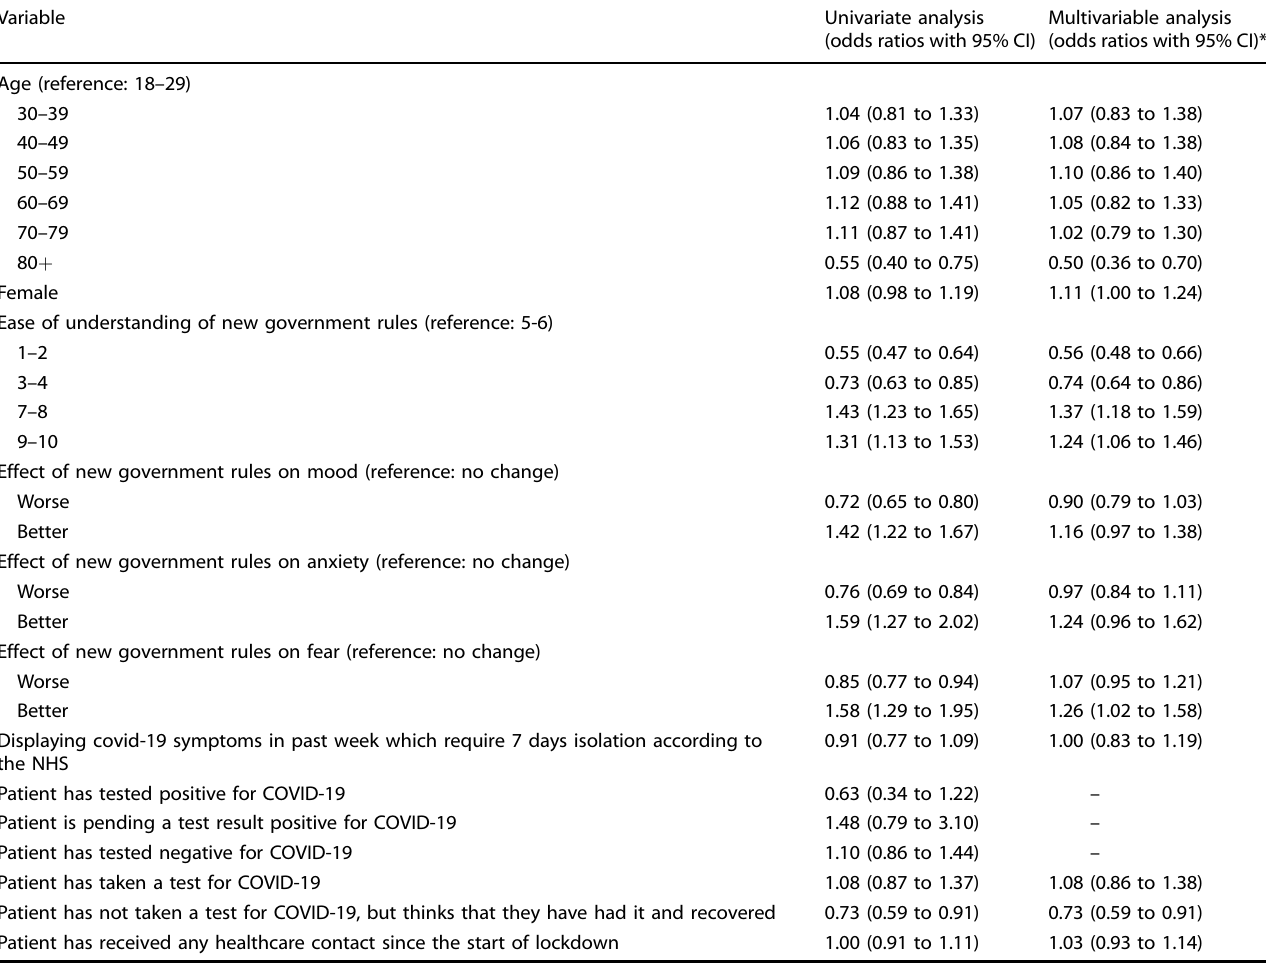
Table presents results for univariate logistic regression analyses and multivariable logistic regression adjusted for every other variable in the model. Multivariable analysis performed on 9512 patients. Those who answered unsure ( N = 2799) or were missing data for any other variable ( N = 123) were not included in the analysis. Univariate analysis performed with the variable of interest as the only predictor in the model. Multivariable analysis adjusted for every other variable in the model. Only patients responding yes/no to receiving a test were included in the model due to low numbers in the groups testing positive and awaiting a test result.